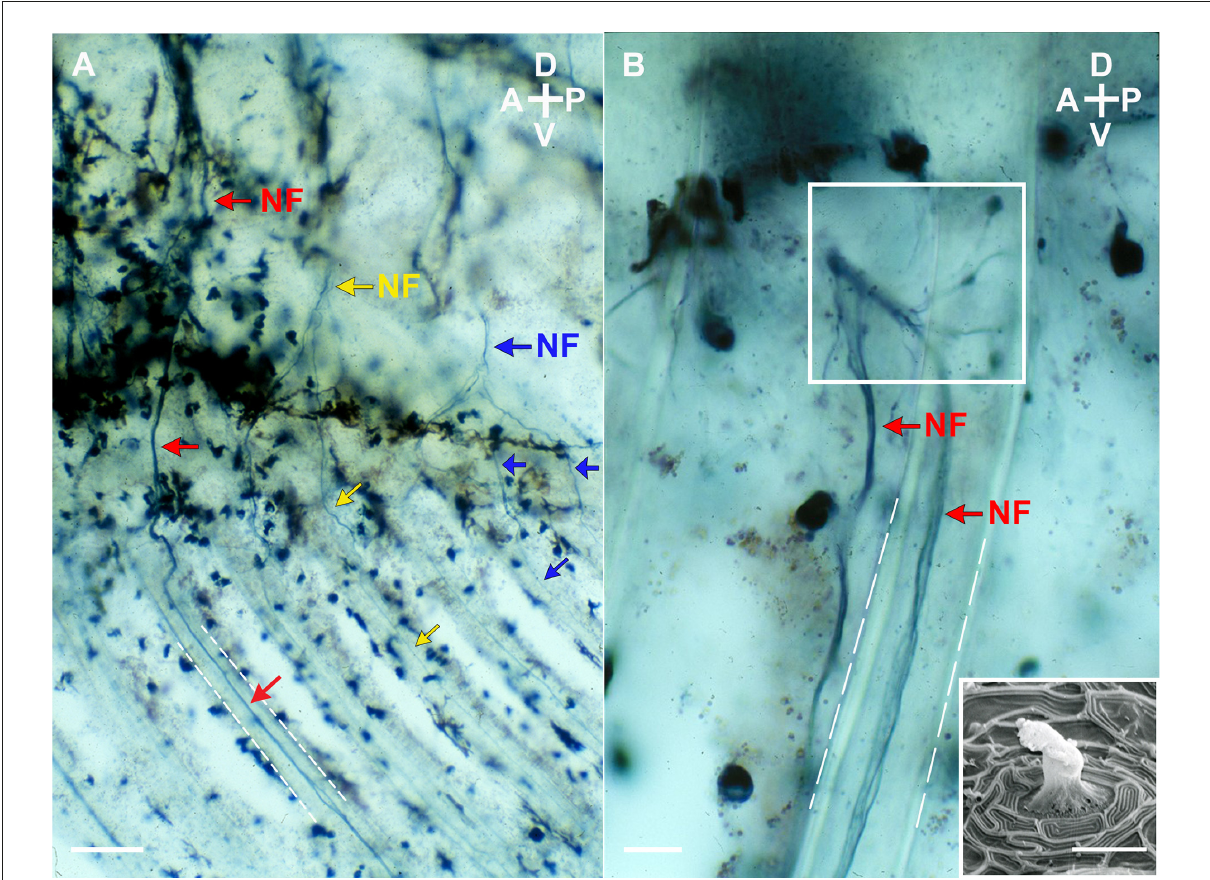
FIGURE1 Lateral view ( A and B ) of nerve fibers projecting ventrally from the 14th ventral root to the base and the fin rays (white dashed lines) of the gonopodium of an adult male mosquitofish. Nerve fibers (NF; red, yellow, and blue arrows as three representative fibers) were anterograde labeled with biotinylated dextran amine (BDA; Life Technologies, ThermoFisher Scientific, Grand Island, NY) and visualized with 3,3’,5,5’- Tetramethylbenzidine (TMB; Vector Laboratories, Burlingame, CA) a blue chromogenic substrate. Note in (B) that the BDA-labeled TMB visualized nerve fibers branch into superficial neuromasts clustered at the base of the gonopodium (see square). (Insert image in B ) Scanning Electron Micrograph of a superficial neuromast from an adult male mosquitofish. Image in (A) and (B) were acquired on an Olympus Bright-field microscope (BH2 model) with an Olympus D Plan 10PO 10 × /0.25 NA and an Olympus A 40 40 × /0.65 NA objectives. Insert image in (B) was acquired on a cold field emission Scanning Electron Microscope (cfe-SEM; S4700 Type I, Hitachi High Tech America, Inc. Dallas, TX) with a secondary electron detector. Scale bars = 10 µ m ( A and the electron micrograph) and 50 µ m (B) . A, anterior; P, posterior; D, dorsal; V,